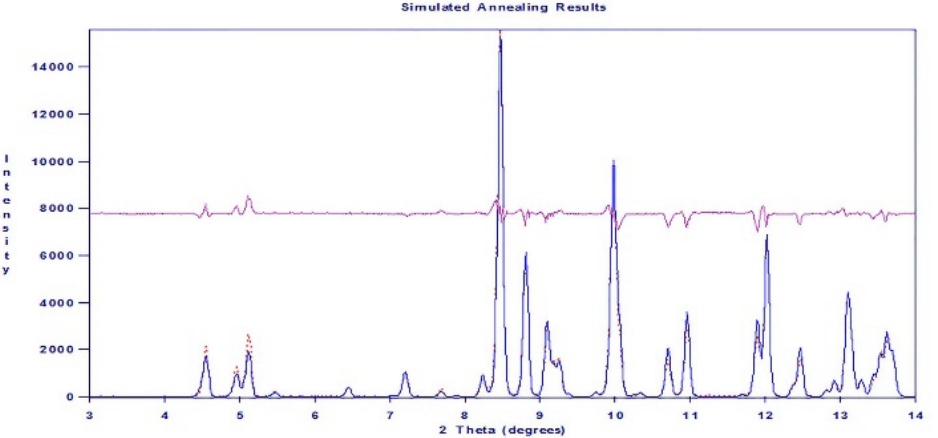
Figure 2: Fit to the experimental powder pattern of the best-simulated annealing solution for the molecule. The measured pattern(red), calculated pattern(blue), difference profile (magenta).